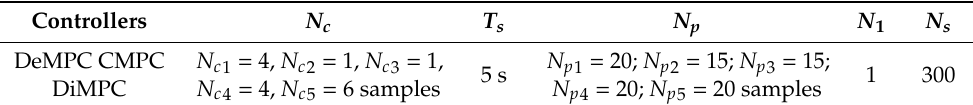
Table 2. The parameters applied in various MPC controllers.